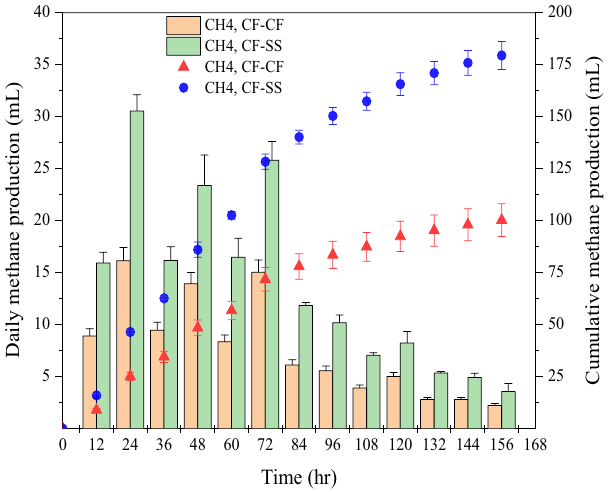
Figure 1. Methane production from CF–CF and CF–SS reactors. The error bars indicate the standard deviation of three replicates (n =